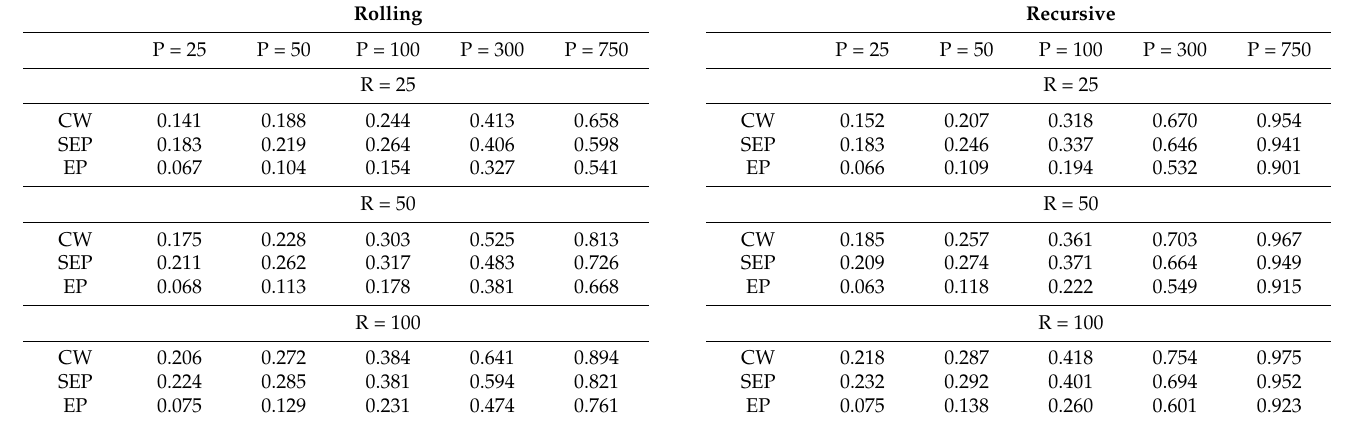
Table 3. Raw Power DGP1 (Nominal Size of